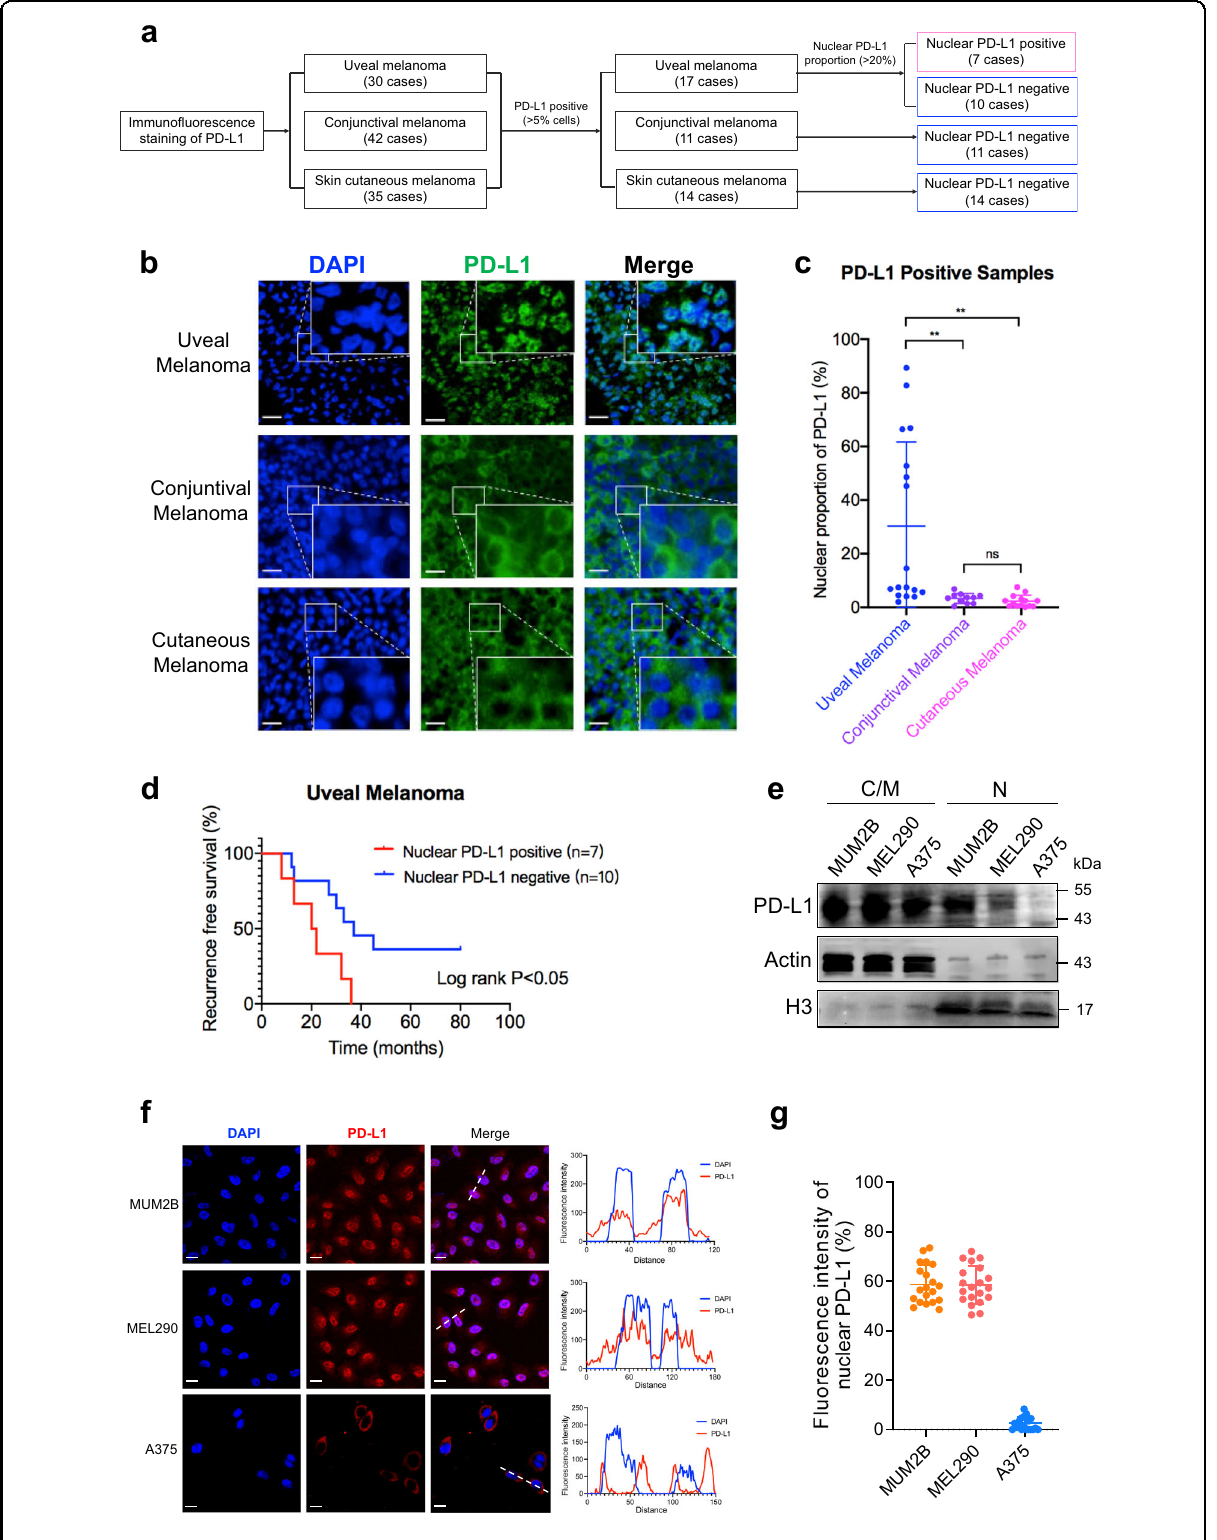
Fig. 1 (See legend on next